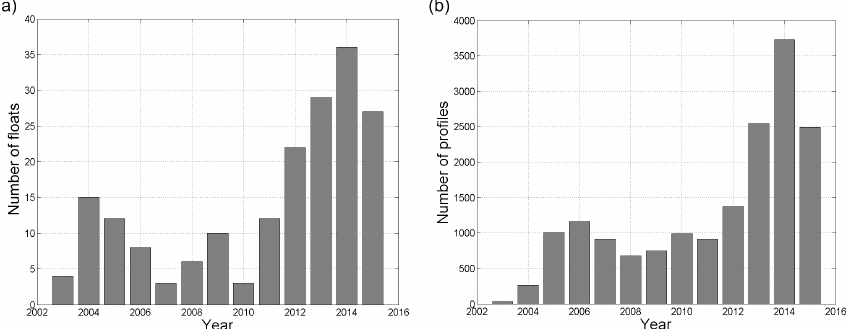
Figure 2. Temporal evolution of Argo floats (a) and Argo profiles (b) with a position quality flag of 1 deployed in the Mediterranean Sea since 2003 until the middle of